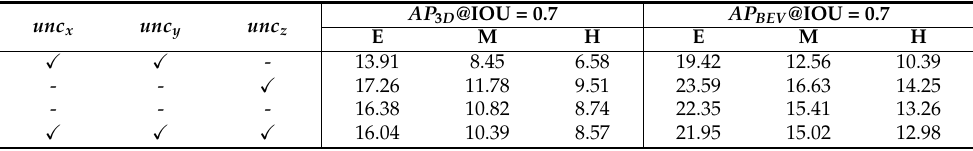
Table 6. Evaluation for the influences of uncertainty unc x , unc y , and unc z settings: E, M, and H indicate the levels from Easy, Moderate, to